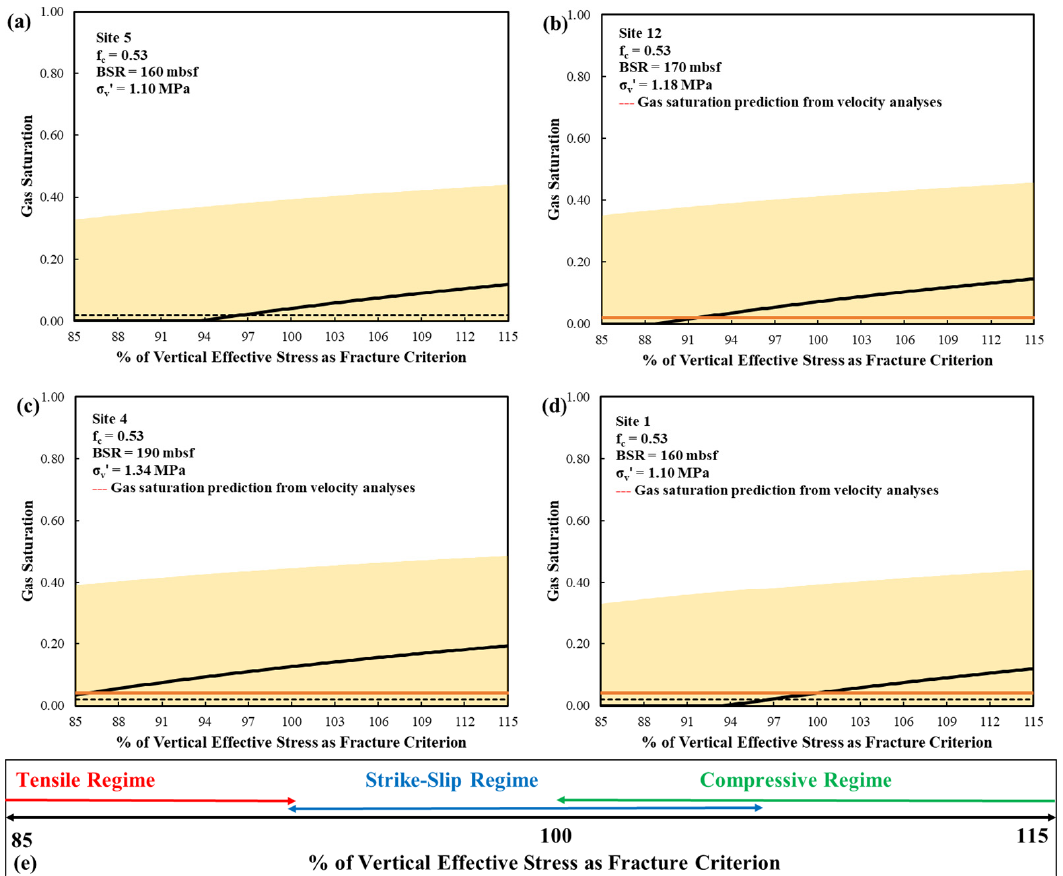
Figure 14. Minimum gas saturation required to open fractures for the 4 sites for varying fracture criterion (represented here as a % of the vertical effective stress). The sites are shown from west to east. Site 5 ( a ) is the westernmost, followed by Site 12 ( b ), Site 4 ( c ) and Site 1 ( d ). The stress regimes and the corresponding fracture criterions boundaries are shown in ( e ). The orange line shows the gas saturation reported at the respective sites (at BSR depths) from velocity analyses. The black curve is the median gas saturation (obtained by substituting equation 7 into equation 13 and solving for the saturations) prediction, and the shaded region shows the uncertainty ( ± 1 SD). The black dotted line is the gas mobility threshold.